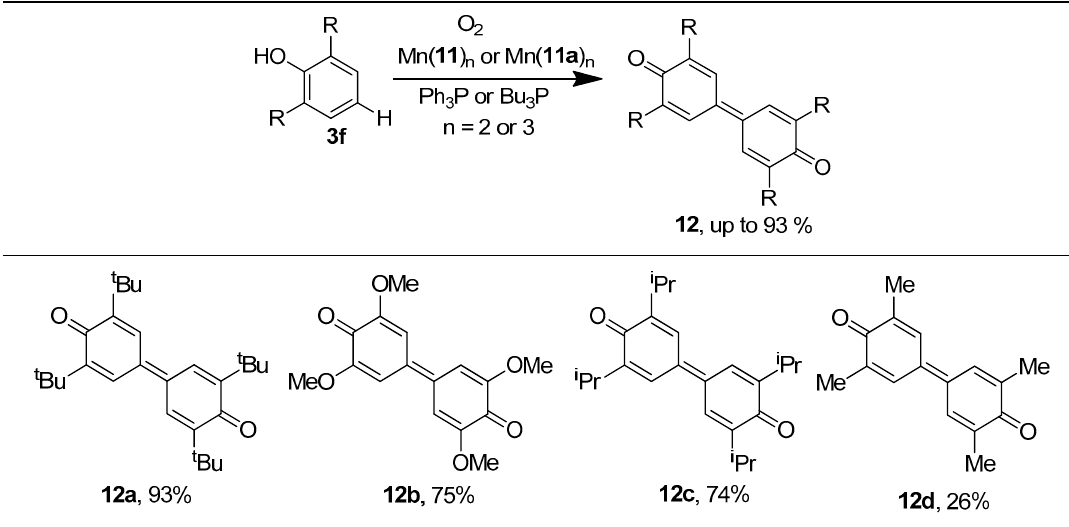
Table 4. The aryl-aryl coupling procedure, with the highest yield reported for the four derivatives [70].